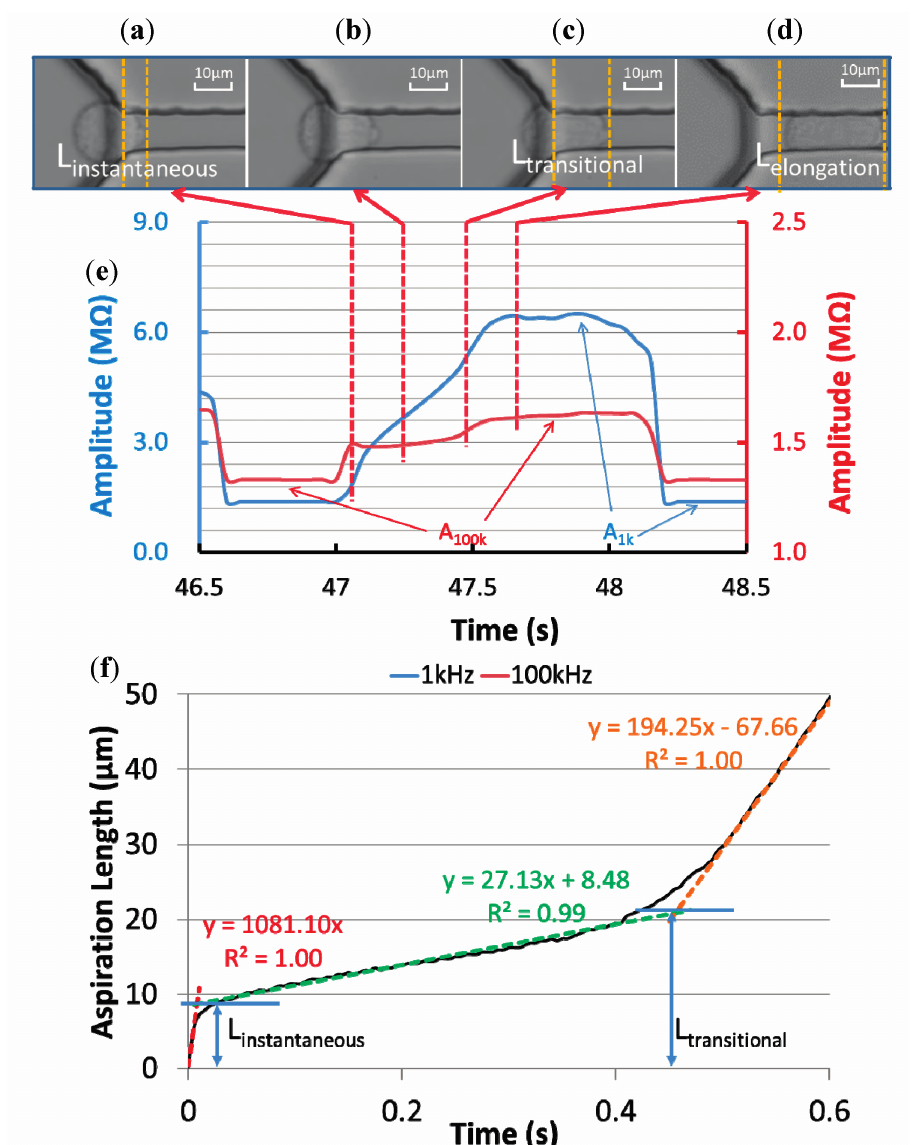
Figure 3. ( a – d ) Microscopic pictures of a 95C cell’s entry process into the constriction channel with raw impedance data of the same cell shown in ( e ) and aspiration length vs. time shown in ( f ). Based on raw data processing, four critical parameters L instantaneous , L transitional , A 1 kHz and A 100 kHz were